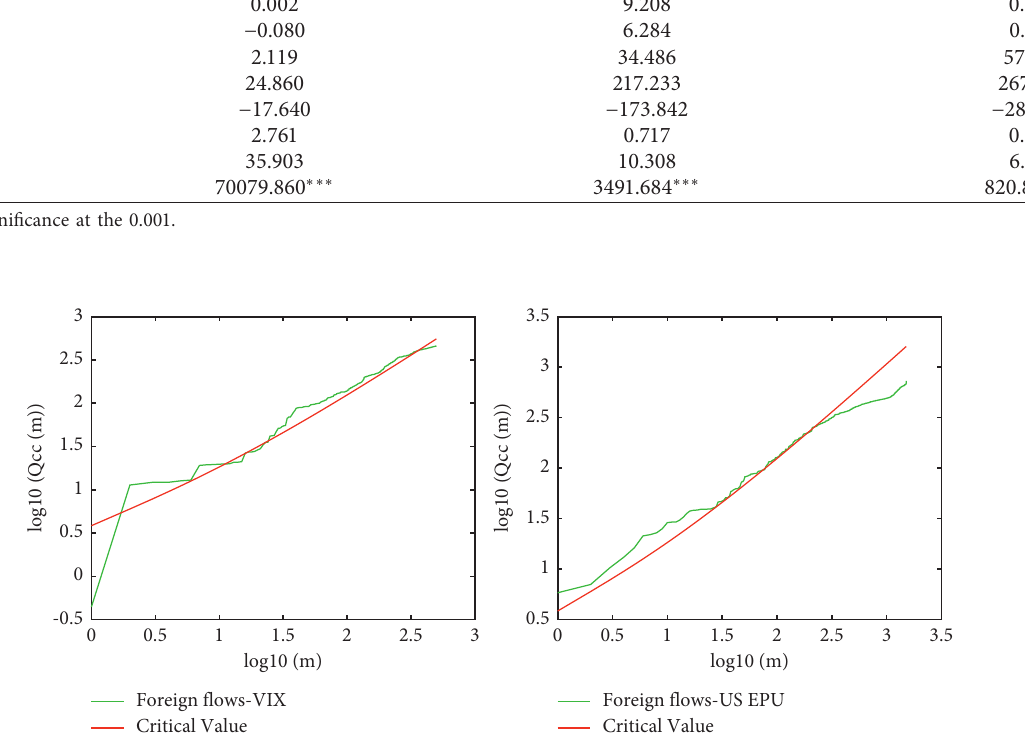
( m ) between the foreign flows in A-share market and VIX and the foreign flows in A-share cc